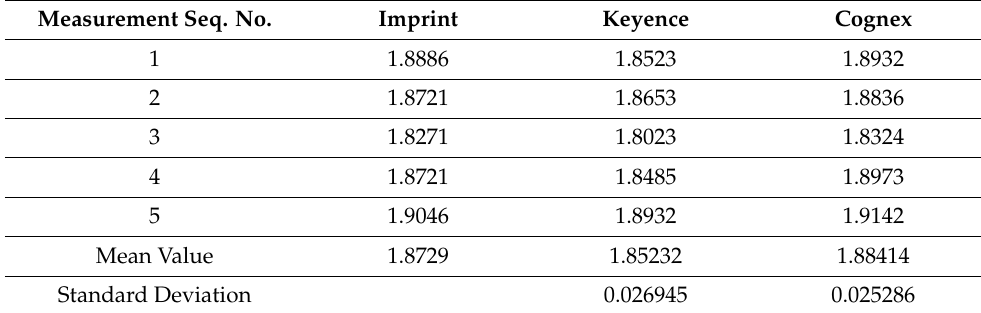
Table 3. Fillet radius R03